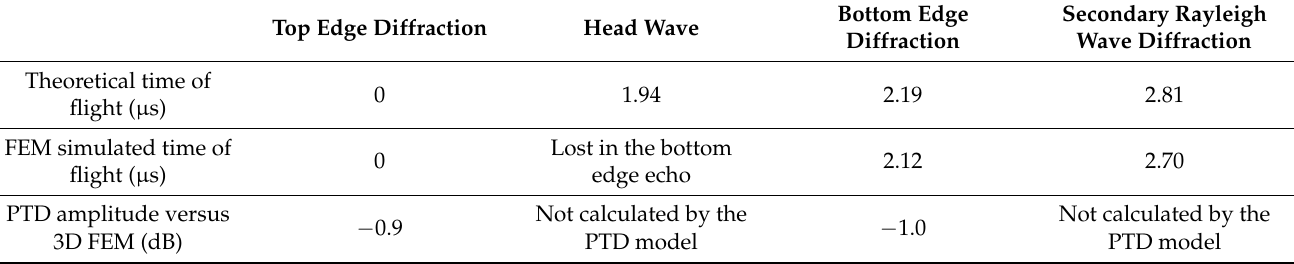
Figure 9. Inspection of a 40 mm extent and 5 mm high rectangular crack inspected using SV45 waves in Pulse Echo mode (circular plane probe of 6.35 mm diameter); Ascans simulated by 3D FEM and 3D PTD: ( a ) at 2.25 MHz ( b ) at 5 MHz with also the normalized Ascan modelled by 2D FEM Civa/Athena. ( c ) S head waves diffracted from a crack (in blue) under 45° incidence: the S wave shed by the bottom tip irradiated by the P creeping wave coming back to the probe at 45° direction and the S head wave radiated during the propagation of the P creeping wave along the crack surface. Table 1. Analysis of Ascans simulated by 3D FEM and 3D PTD of the inspection of a 40 mm extent and compared to that obtained after 3D FEM simulation (see Table 1). and 5 mm high rectangular crack using SV45 waves in Pulse Echo mode (circular planar probe of 6.35 mm diameter) at 5 MHz: time of flight of the different waves theoretically calculated using ray theory or obtained after 3D FEM simulation; PTD amplitude versus 3D FEM